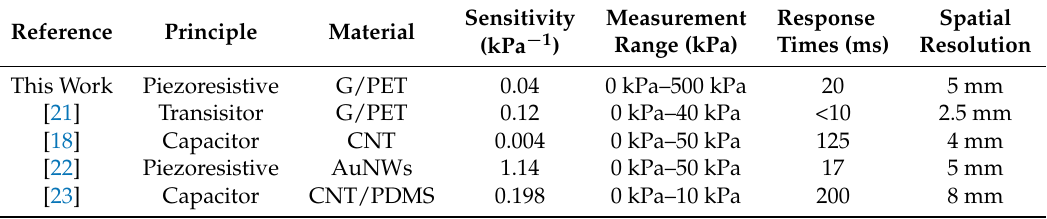
Table 1. Comparison between the performances of this work and